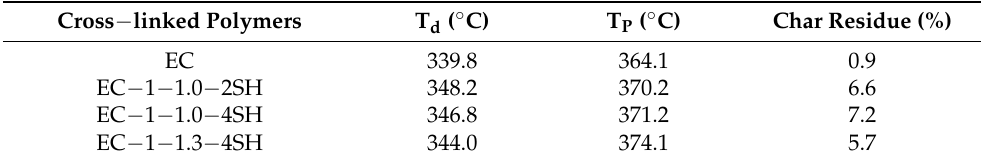
Figure 18. TGA ( a ) and DTG ( b ) curves of the cross − linked polymers. Table 4. T d, T P and char residue of the cross − linked polymers.